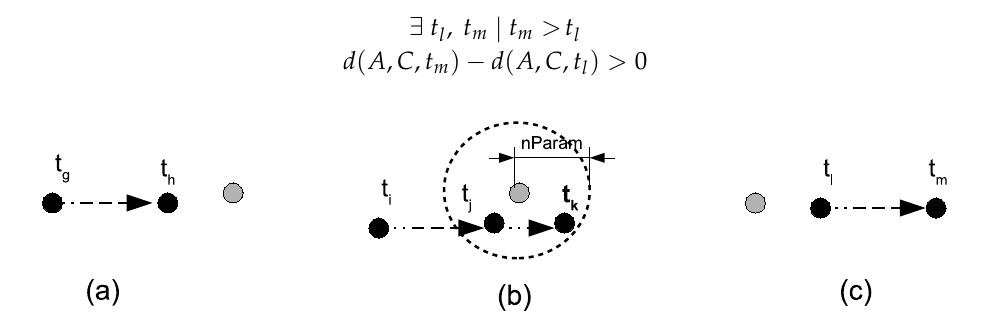
Figure 1. Interactions between a moving object (black) and a context element (grey): ( a ) approaching; ( b ) stopping; ( c ) moving-away.